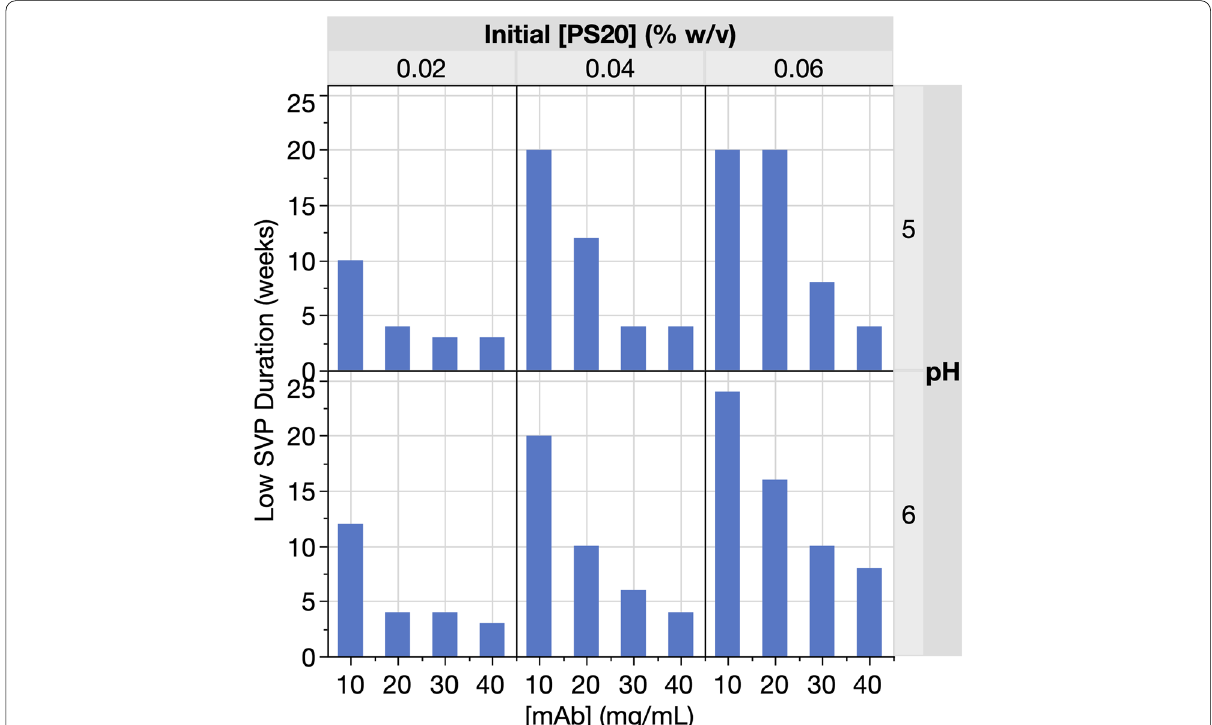
Fig. 4 Storage duration with low SVP counts in mAb X DP as a function of [mAb]. The 24 formulations were stored at 5 °C and represent unique combinations of [mAb], initial [PS20], and pH as listed in Table 1. For each formulation, the duration with low cumulative SVPs (< 350 counts for 2 µm particles/mL) was determined by SVP measurements (using HIAC liquid particle counter) at 12 time points over 24 ≥